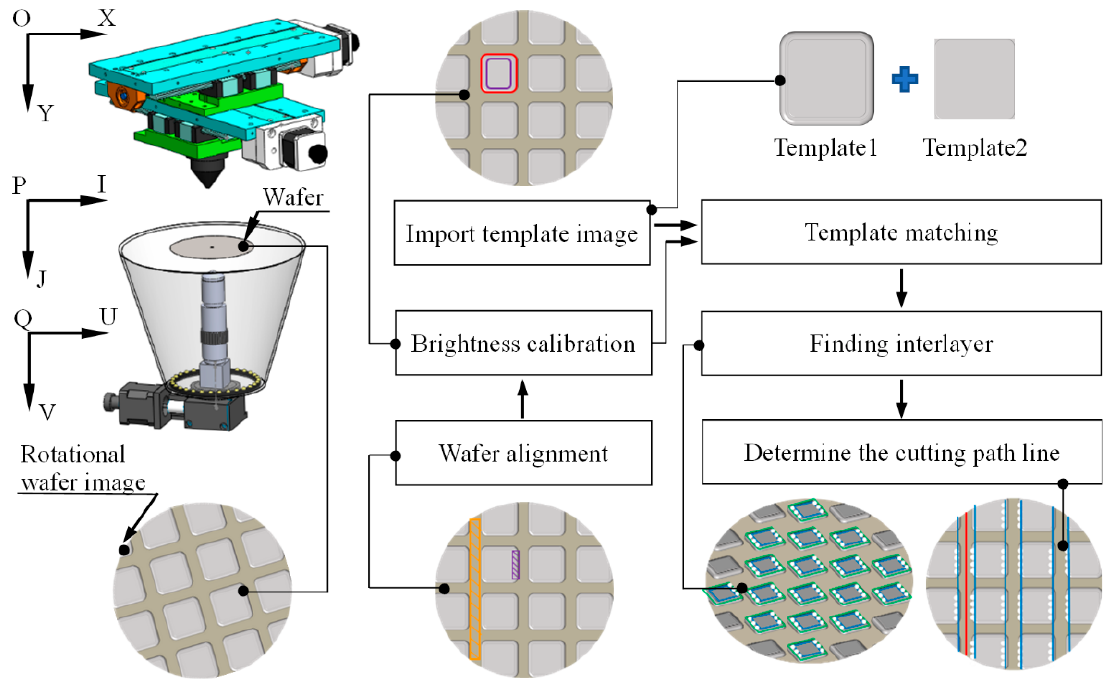
Figure 5. An algorithm for determining the cutting path of wafer image.